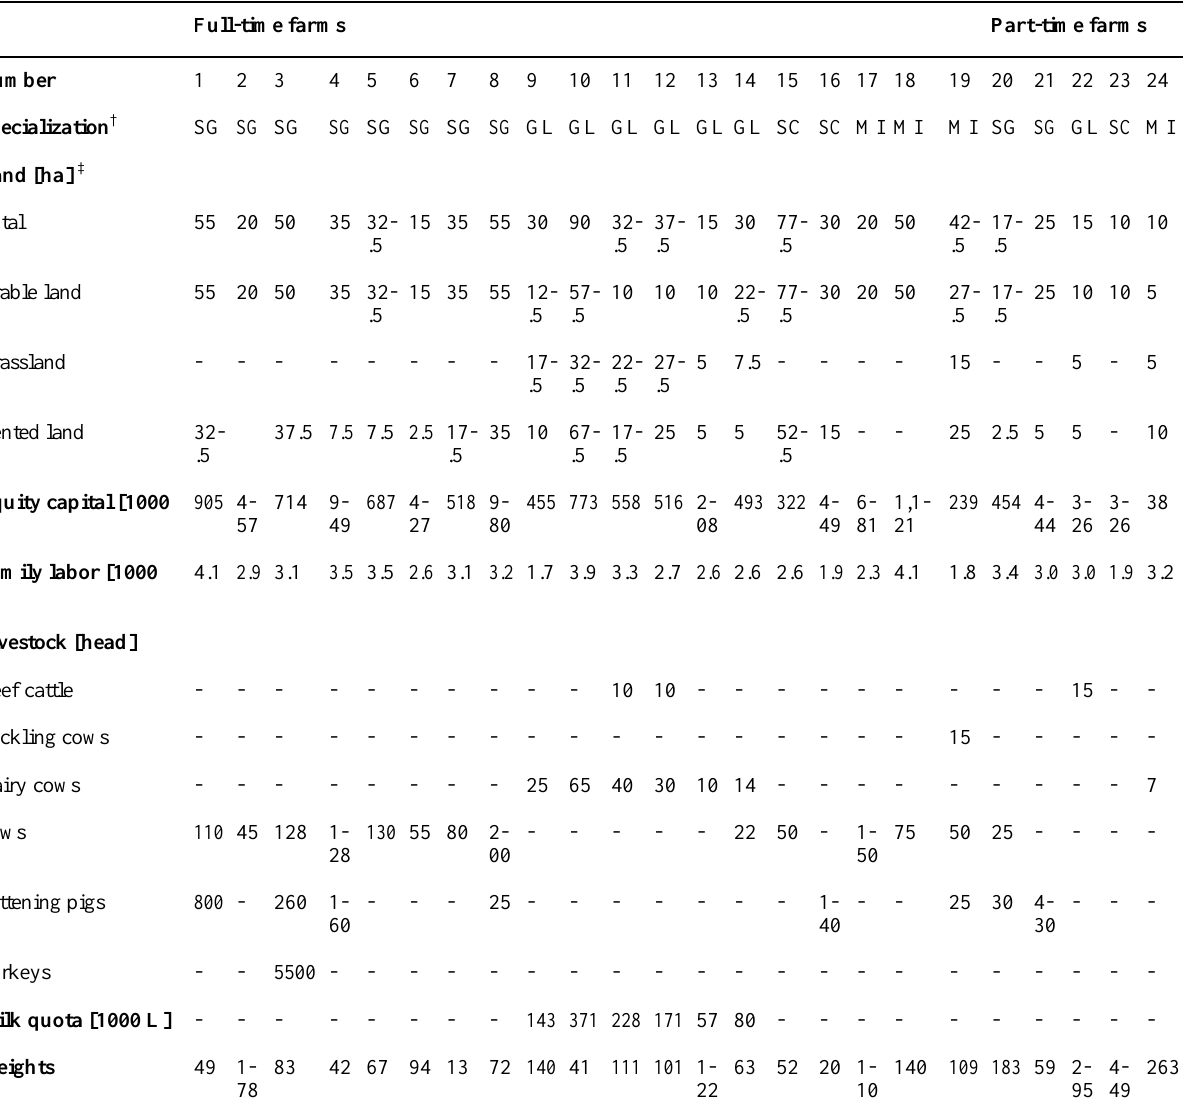
Table 3. Full factorial design matrix for 25 possible factor combinations: (-) denotes low factor level, (+) denotes high factor levels. † SC stands for specialized field crop farm, GL for grazing livestock farm, SG for Intensive livestock farm, and MI for Mixed farm based on German classification before 2002 with a threshold at 50% of total standard gross margin. ‡ Land endowment is adjusted to fit a plot size of 2.5 ha assumed in AgriPoliS. Source: Sahrbacher et al. (2005).